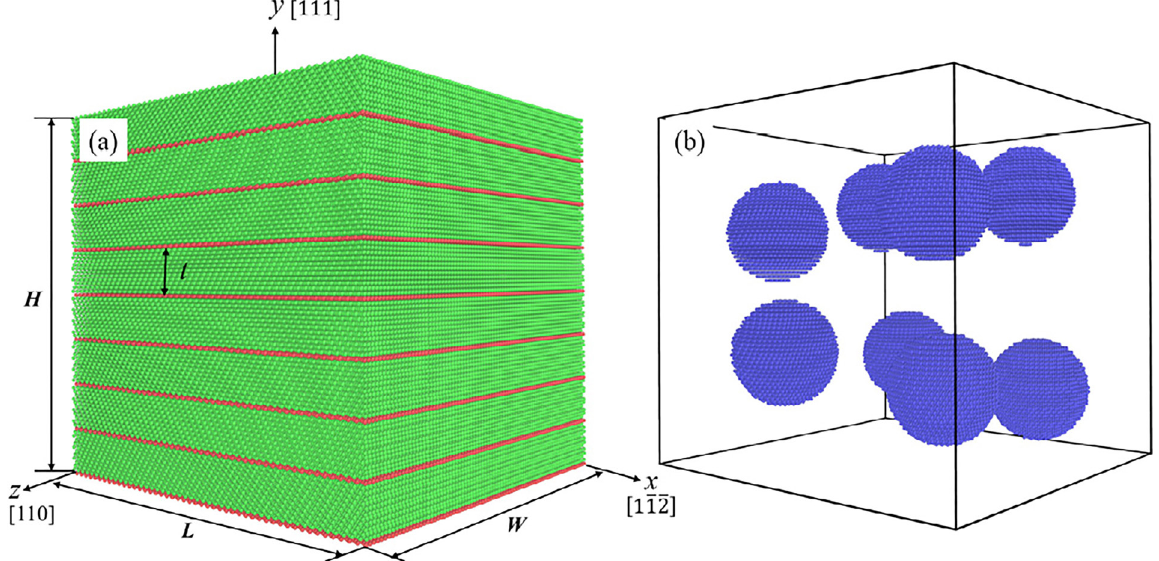
Figure 12: The three-dimensional schematic diagram of the simulated nano-twinned Cu with spherical Ag inclusions [64] (a) Simulation model (b) The same structure without Cu atoms. In addition, the green and red atoms are respectively the atoms which are in local fcc and hcp lattices. The blue atoms represent the silver